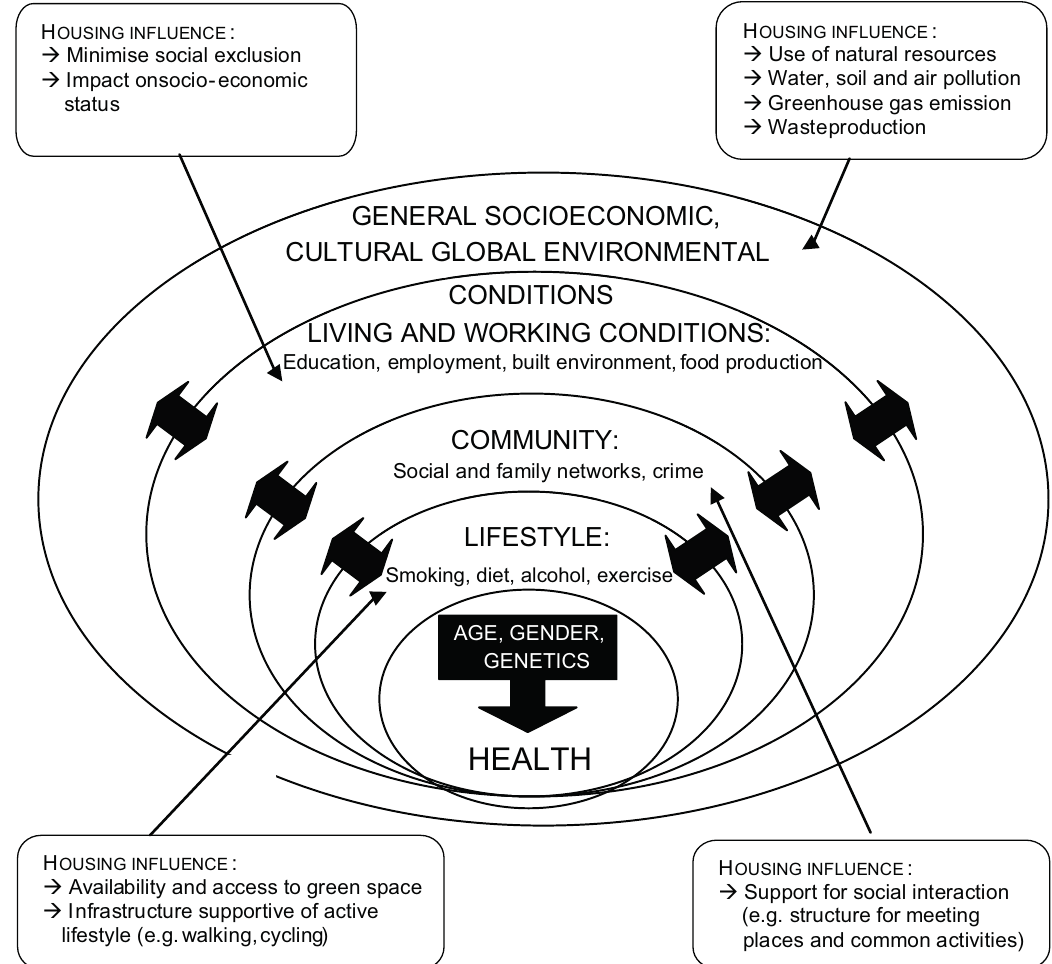
Figure 1. The determinants of health (adapted from Dahlgren and Whitehead,